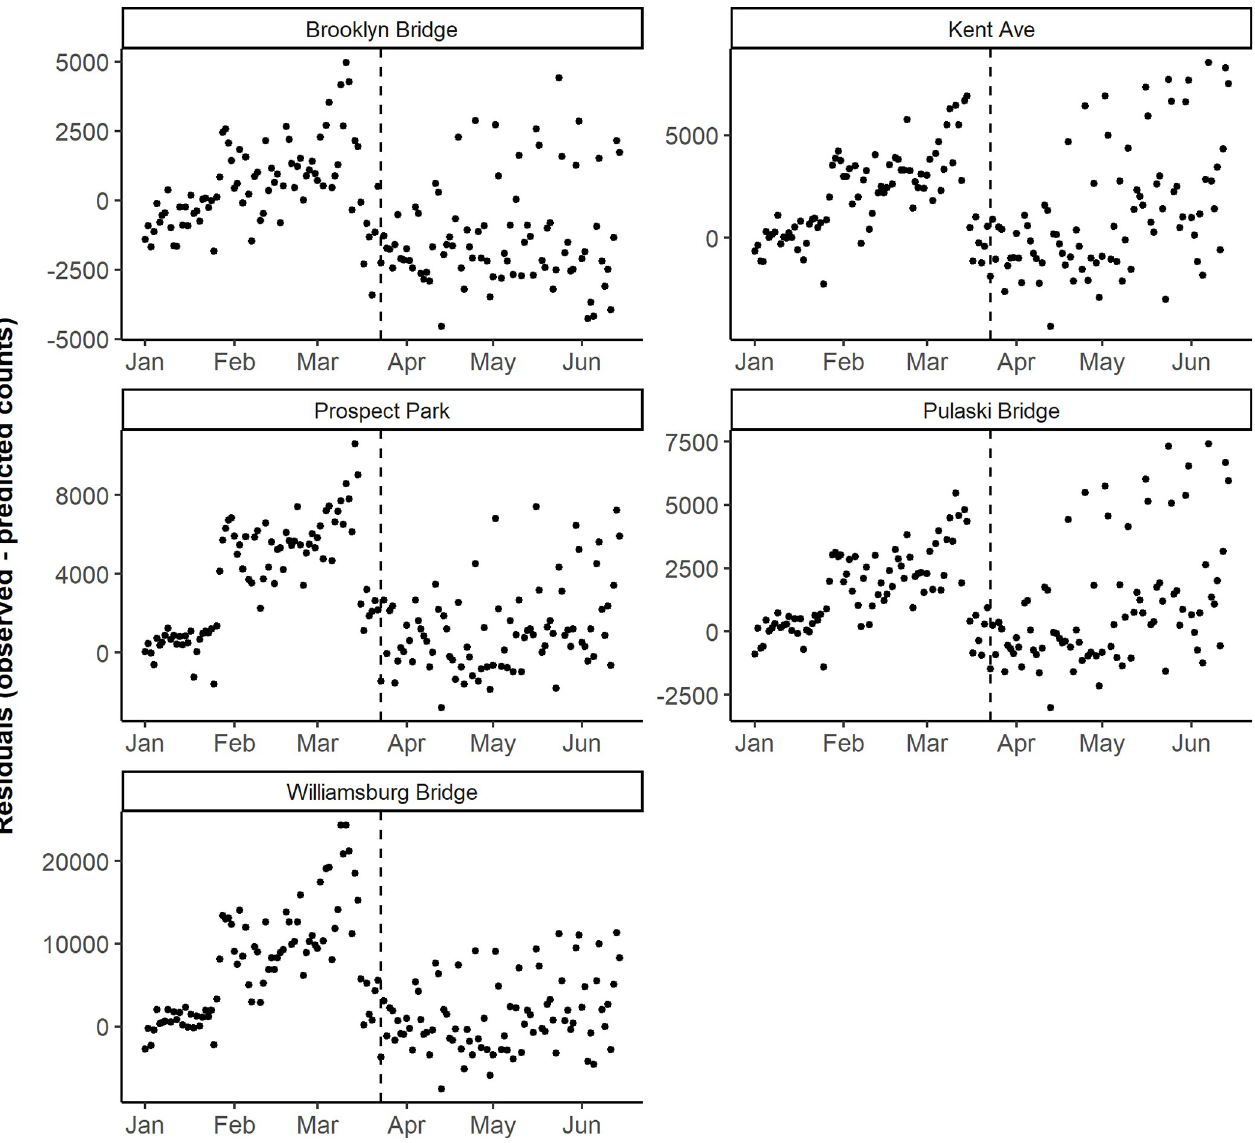
Fig 4. Daily observed minus predicted bicycle counts by counter location, before and during the Stay Home order in New York City. The vertical dashed line corresponds to the Stay Home order on March 22, 2020 in New York State. Note the y-axis scales vary between plots to facilitate the interpretation of